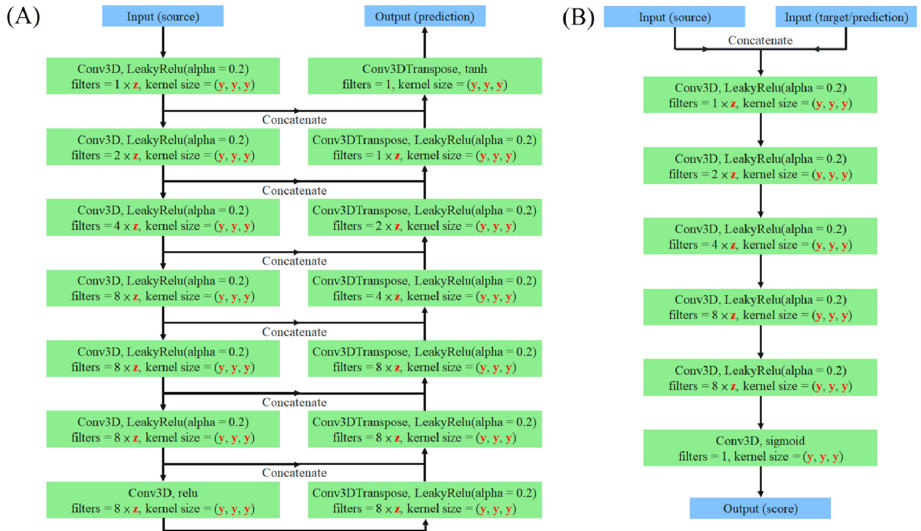
Figure 3. The structure of 3D pix2pix model. A single pix2pix model contains the ( A ) u-net and a ( B ) PatchGAN classifier. The task of u-net is to learn the relationship between “source” and “target” and make the distribution of “prediction” approach the distribution of “target” as similarly as possible. In contrast to u-net, the PatchGAN classifier needs to learn how to cause a high score for the real pair of “target” and “source” rather than the pseudopair of “target” and “prediction”.